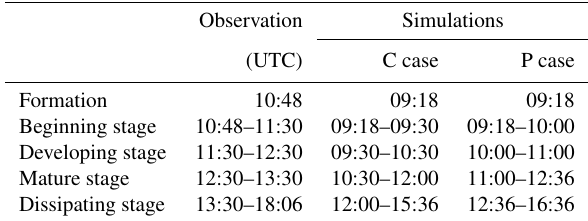
Table 2. Temporal evolution of the thunderstorm.